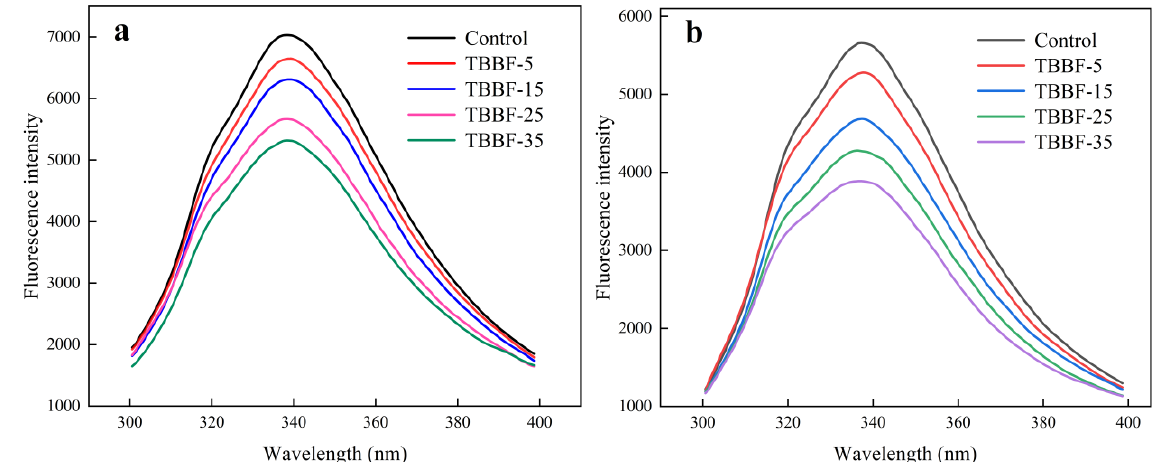
Figure 4. Fluorescence spectra of α -amylase ( a ) and amyloglucosidase ( b ) of Tartary buckwheat dried noodles with different substitutions of Tartary buckwheat bran flour. Control, TBBF-5, TBBF-15, TBBF-25, and TBBF-35 represent Tartary buckwheat dried noodles with 0%, 5%, 15%, 25%, and 35% substitution of Tartary buckwheat bran flour,